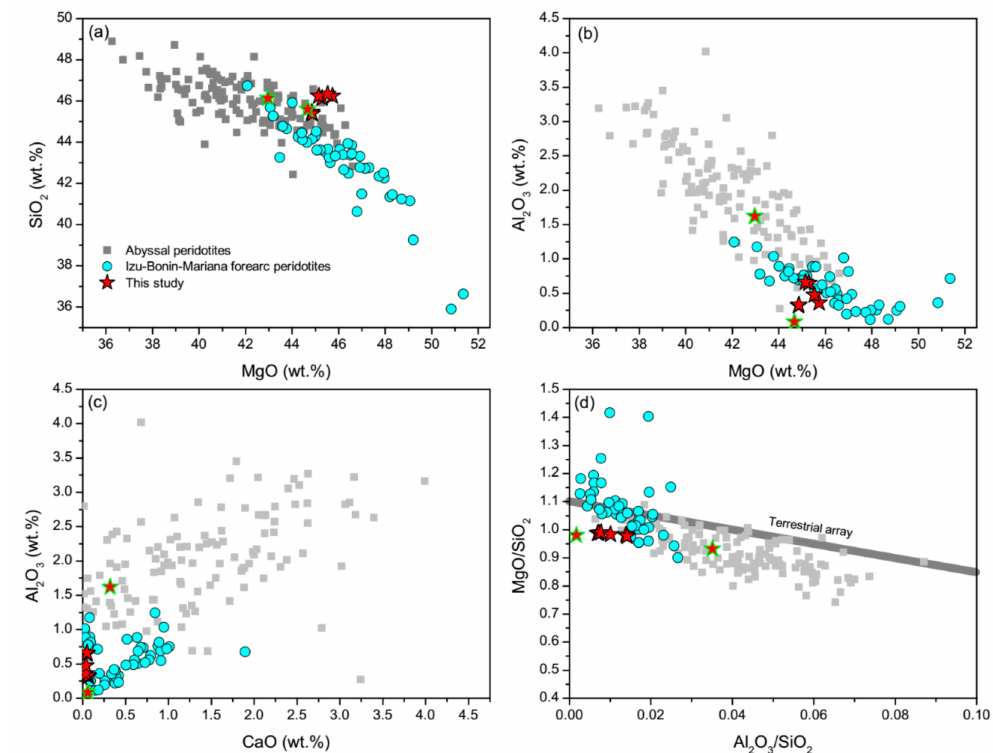
Figure 2. Plots of MgO versus ( a ) SiO 2 and ( b ) Al 2 O 3 , ( c ) CaO versus Al 2 O 3 , and ( d ) Al 2 O 3 / SiO 2 versus MgO / SiO 2 of the studied Yap Trench peridotites (stars). Samples from the southern Yap Trench are shown by stars with green border. Concentrations have been recalculated to 100% on a loss on ignition (LOI)-free basis. The abyssal peridotites [38] and peridotites from the Izu–Bonin–Mariana forearc [39,40] are shown for comparison. The thick gray line in ( d ) represents the terrestrial array [41]. The Yap Trench peridotites show light rare earth element (LREE)-rich patterns in the chondrite-normalized diagram (Figure 3a). Sample JL149-S27-1 from the southern Yap Trench has a heavy rare earth element (HREE) content comparable to the average value of abyssal peridotites, while other samples have HREE contents similar to that of peridotites from the IBM forearc, which is plotted outside the HREE field of the abyssal peridotites. In the trace elements spider diagram (Figure 3b), the Yap Trench peridotites show a positive peak in Ba, U, and Sr with respect to the adjacent elements. In contrast, Ti shows negative anomalies in samples from the northern Yap